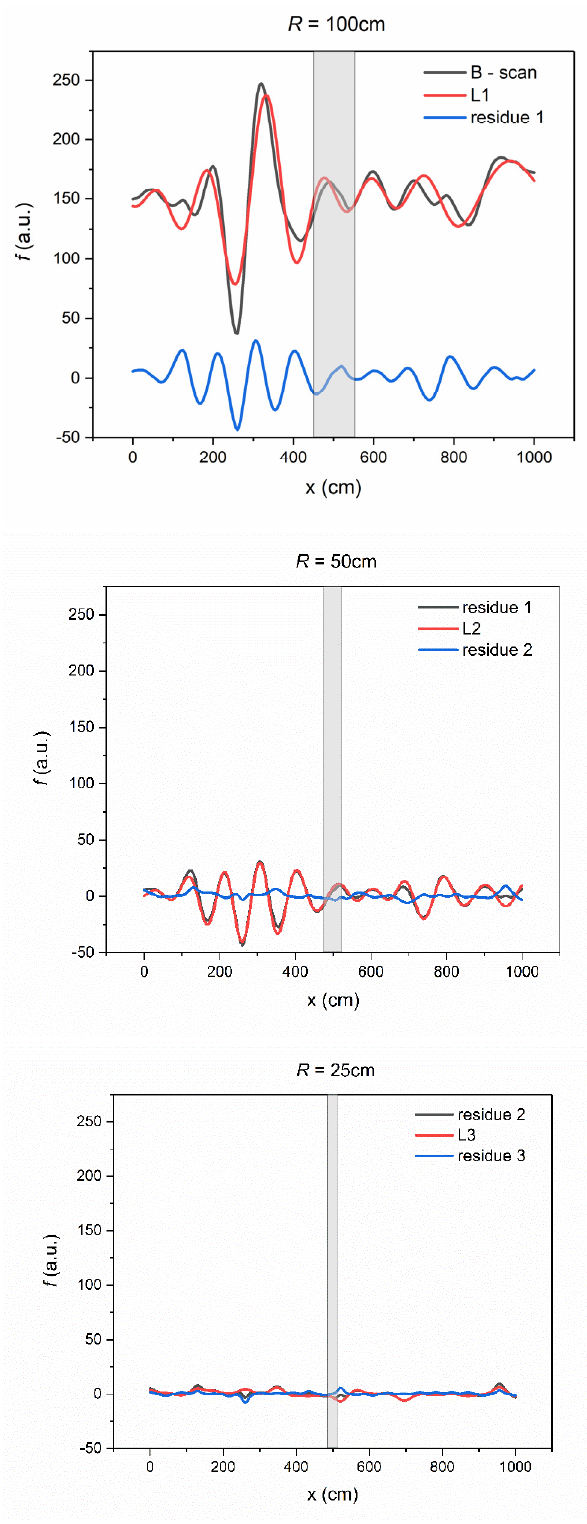
Figure 2. RBF-ML algorithm operation. Residues from successive layers are passed to the next iteration with a radius twice as